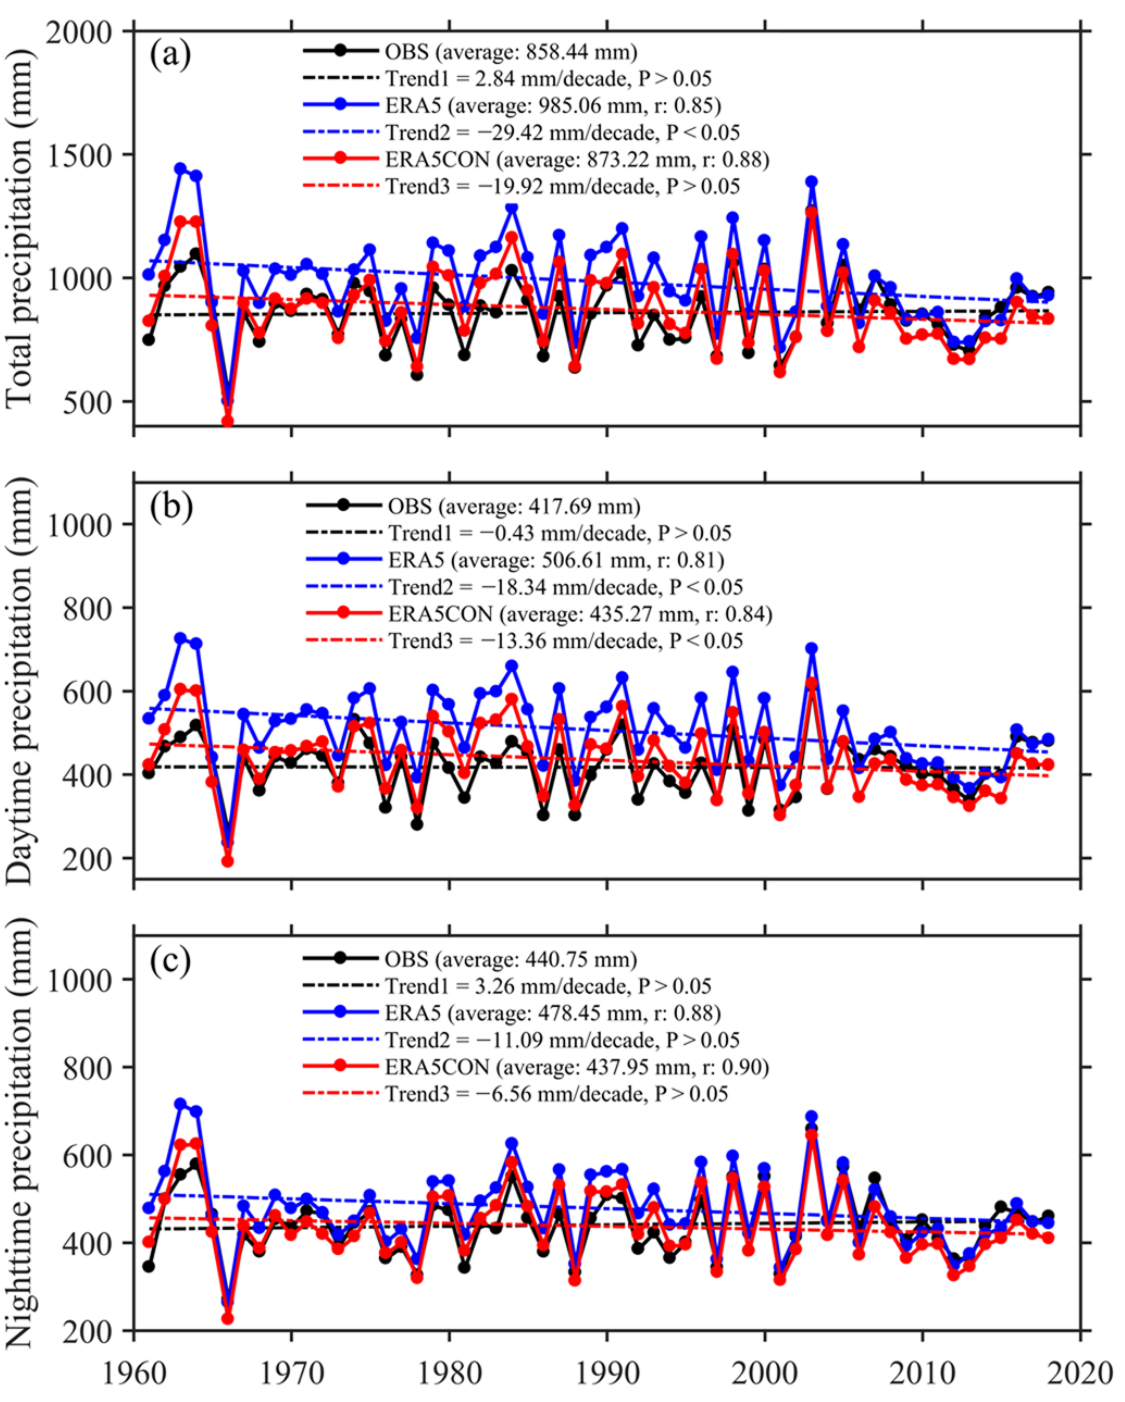
Figure 2. Annual precipitation of ( a ) total (daily), ( b ) daytime, and ( c ) nighttime precipitation per year averaged over the HRB from 1961 to 2018 in the observed, ERA5, and ERA5 under the condition of observed wet days ( ≥ 0.1 mm/day, ERA5CON), respectively. The r denotes the correlation coefficient with the observed value.